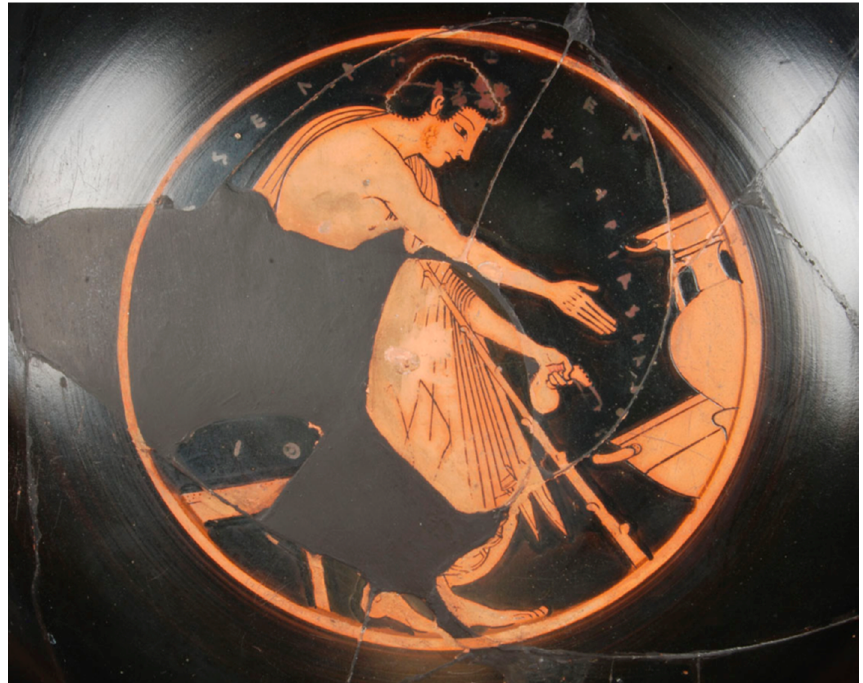
Figure 16. Detail of a red figure cup signed by Phintias as painter, ceramic, Greek, 510 BCE, Image courtesy of the Johns Hopkins Archaeological Museum.